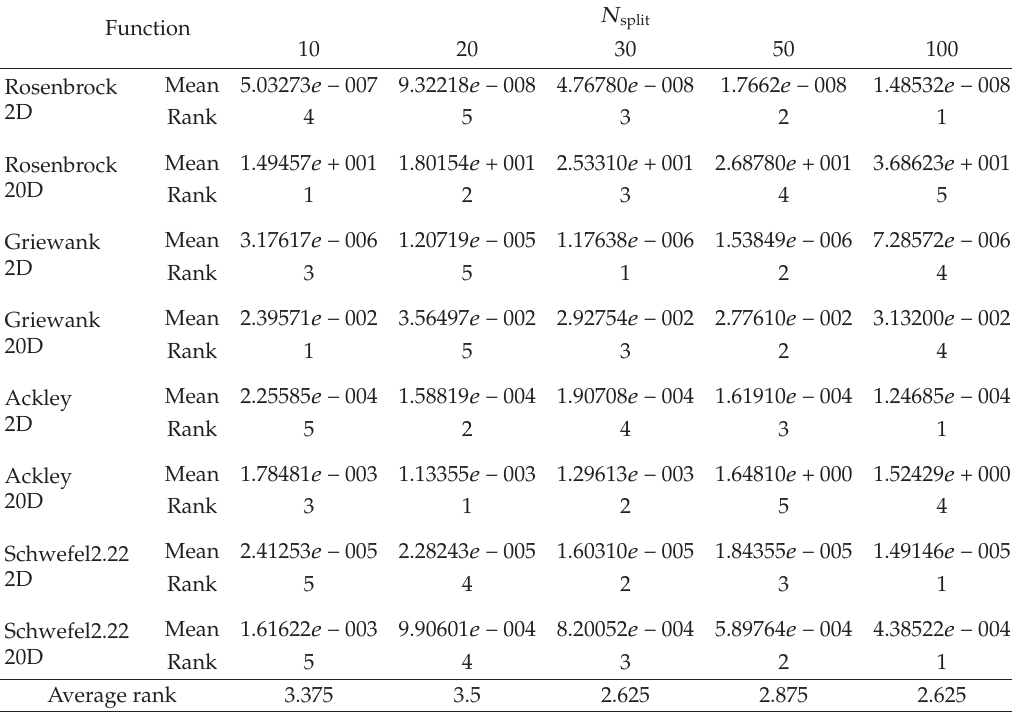
Table 8: Results of BFOLS with di ff erent N split values under N adapt (cid:9)